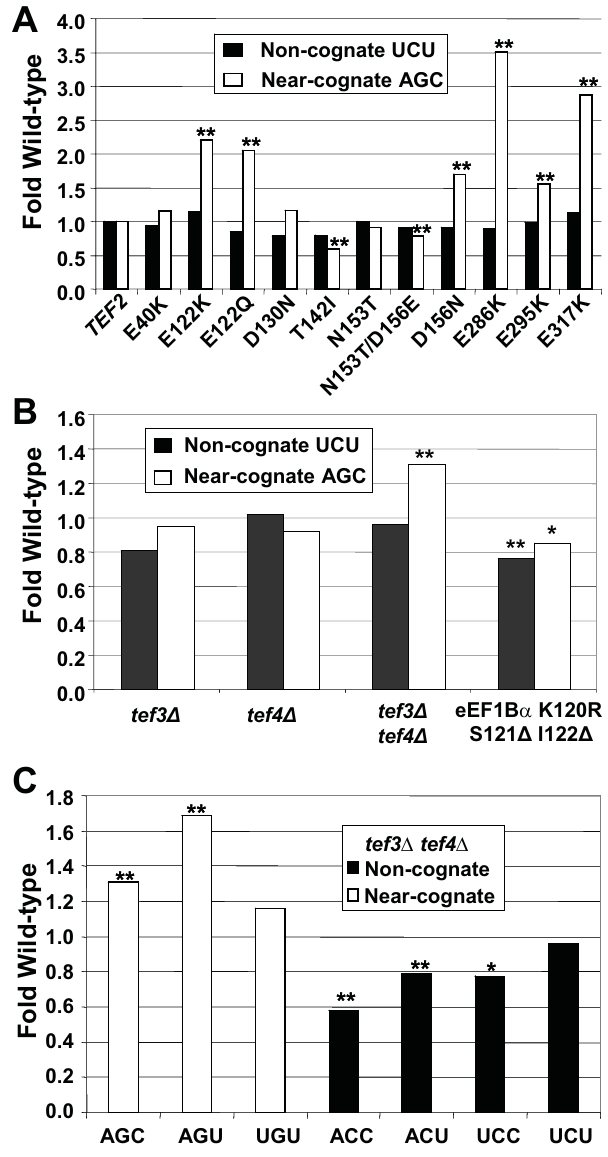
Figure 3. Effects of the eEF1 complex mutants on mis-reading of near- and non-cognate codons. Misreading of the non-cognate UCU and near-cognate AGC codons by mutant forms of eEF1A (Panel A) , or by isogenic strains with tef3 D , tef4 D , or tef3 D tef4 D double null mutants or tef5 D strains expressing the K120R S121 D I122 D allele compared to isogenic wild-type strain ( Panel B ). Panel C. Misreading of all seven missense codons by cells lacking both forms of eEF1B c ( tef3 D tef4 D ). Effects of the indicated mutants are depicted as fold of isogenic wild- type cells. ** indicates p values of , 0.01; * indicates p values of , 0.05.